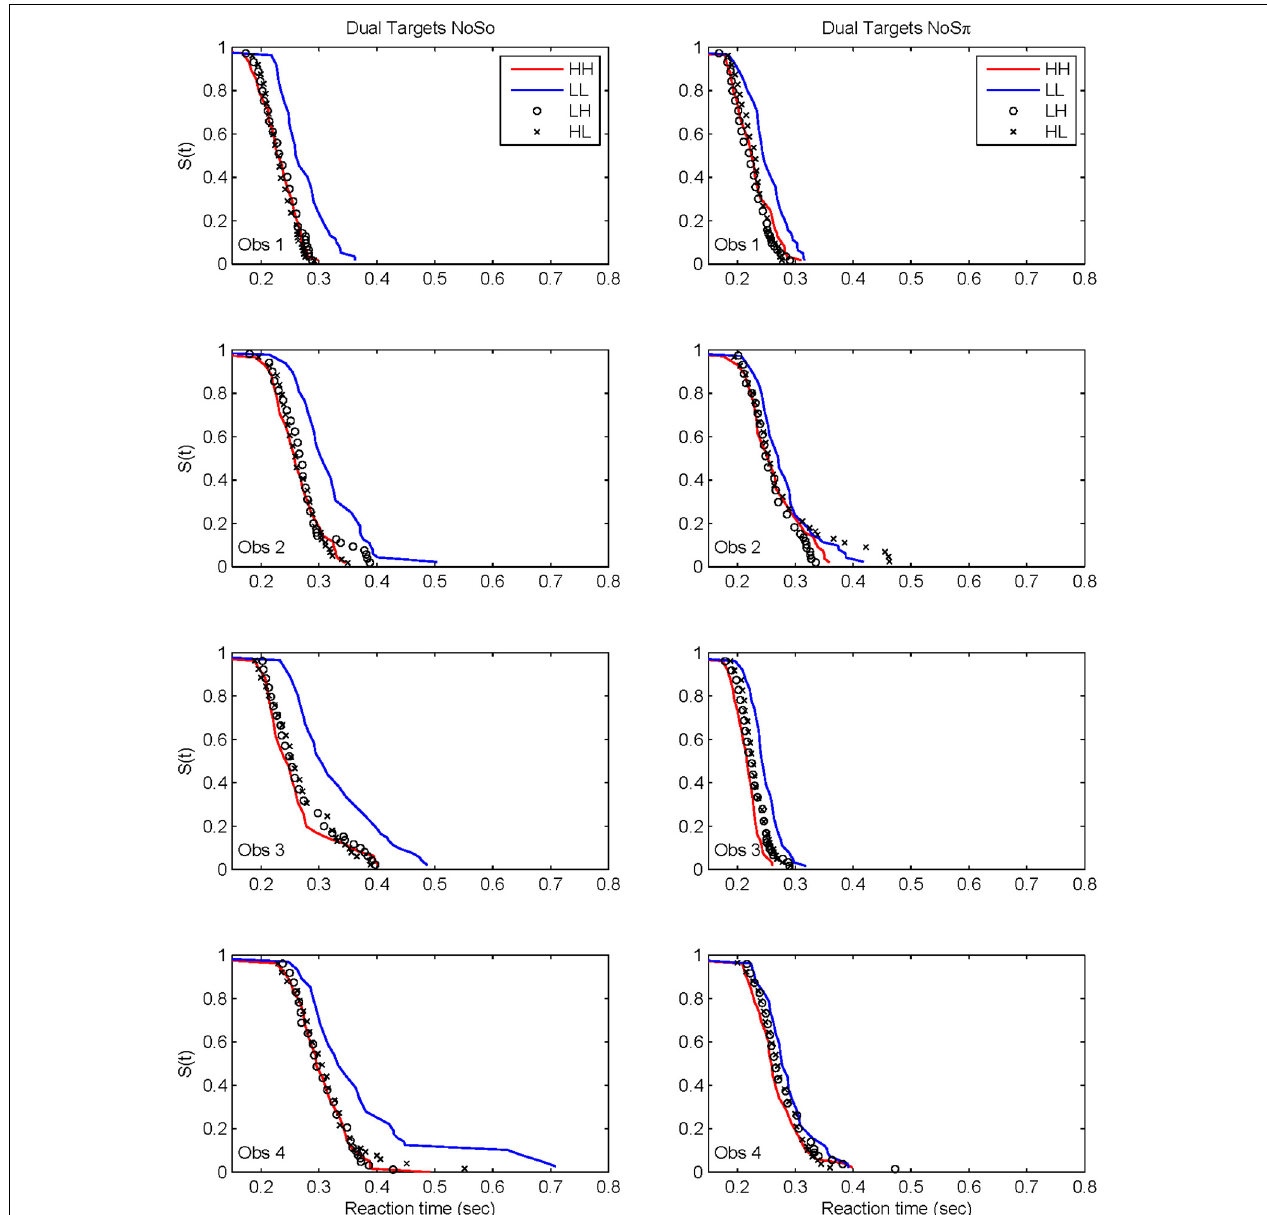
FIGURE 7 | Derived survivor functions for the dual-target conditions in the two contexts: N 0 S 0 (left panels) and N 0 S π (right panels).